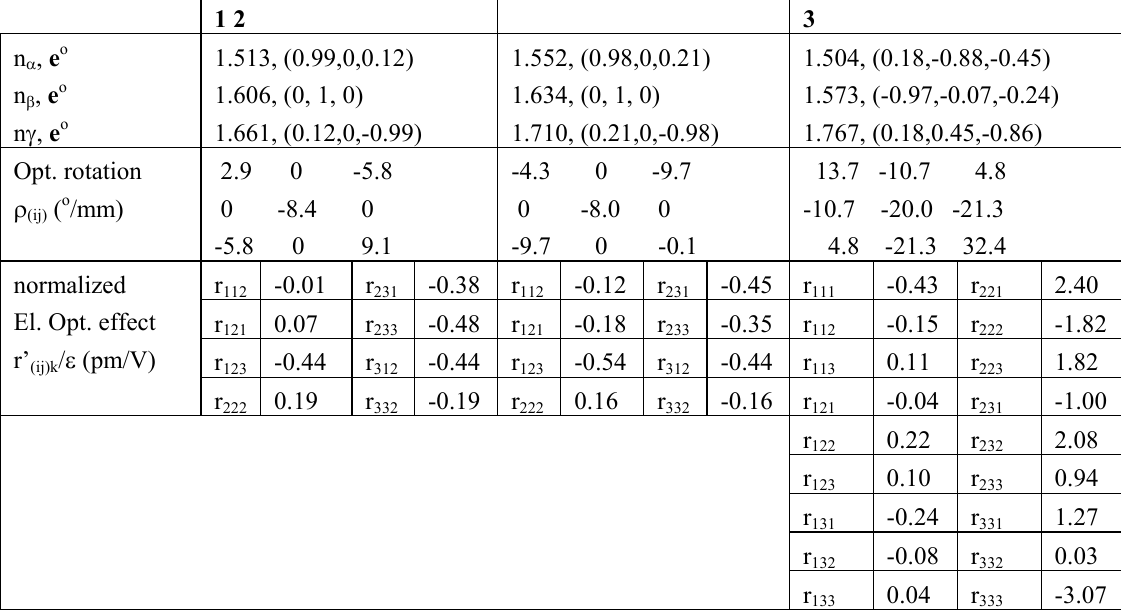
Table 3. Calculation of refractive indices, components of corresponding direction cosines , e o , e o ), optical rotation and normalized static electro-optic effect at constant strain. (e o x y z Realistic r-coefficients may be obtained from calculated r static dielectric constants. Tensor components and directions are related to the physical reference system { x , y , z } via convention y // b* , z // c , x = y x z ; a , b , c crystallographic